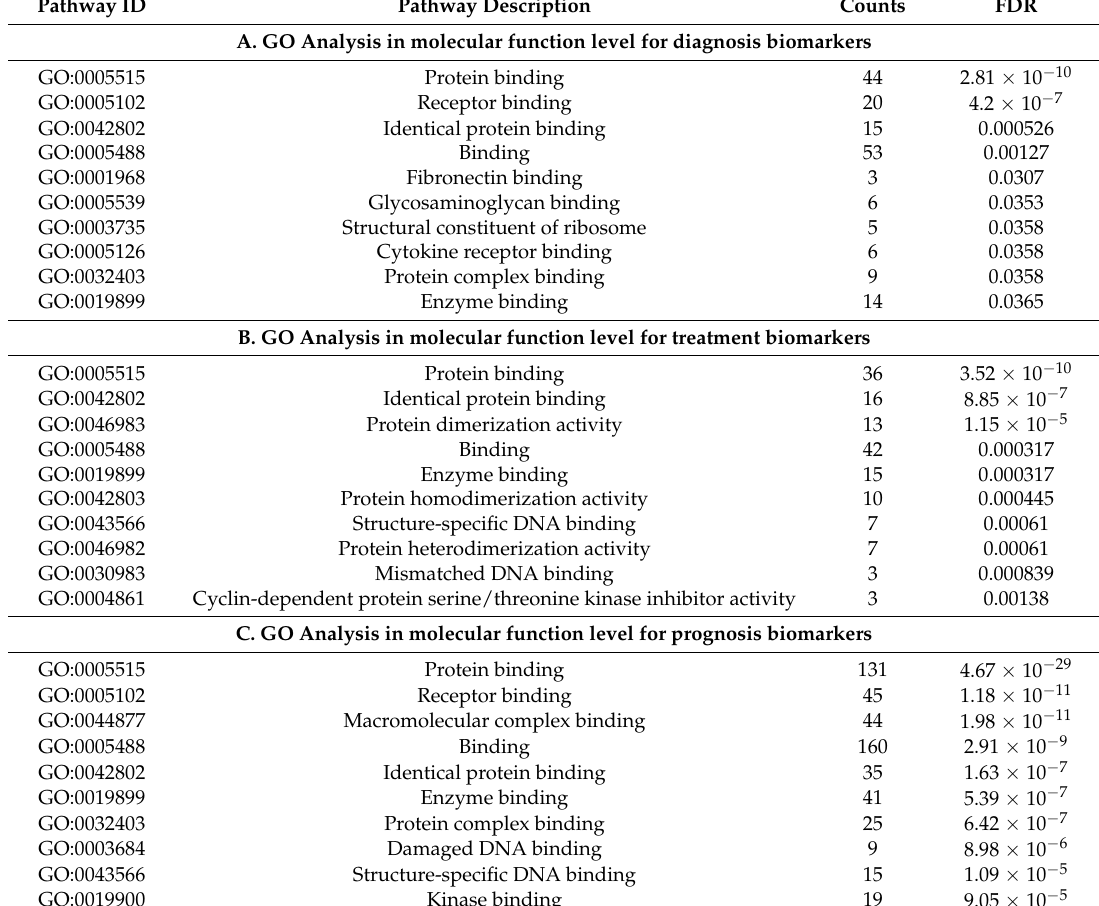
Table 3. GO analysis results in molecular function level for CRC protein